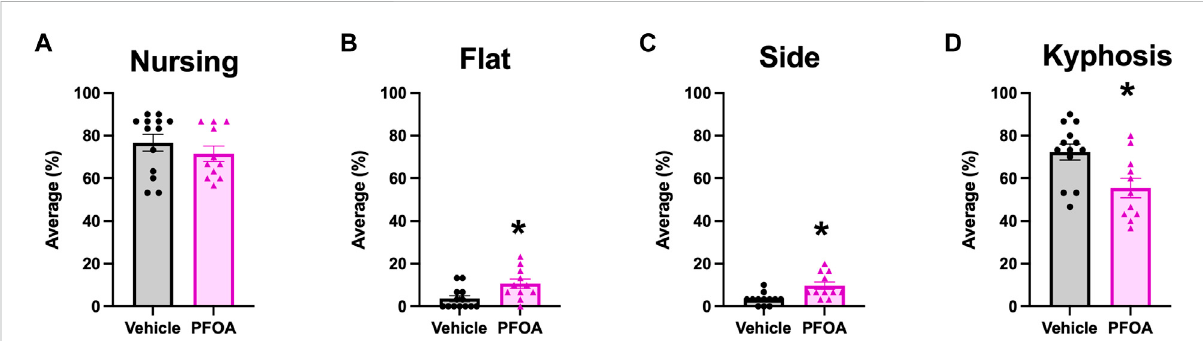
FIGURE 2 DamsNursingActivity.Averageamountoftimeoverpostnataldays5 – 9thatdamsspentnursing (A) ,nursingina fl atposture (B) ,nursinginaside posture (C) , and nursing in a kyphosis posture (D) . Data represented as mean ± standard error of the mean, n = 11/PFOA and n = 12-13/vehicle. Data analyzed with two-sided student ’ s t-test. Asterisks means p ≤